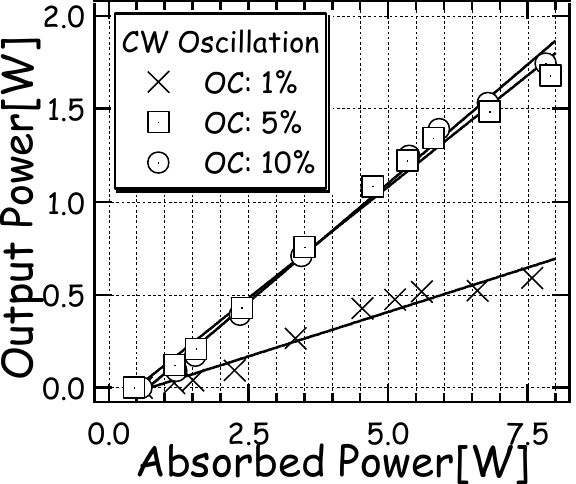
Figure 25. CW Output Power versus absorbed pump power for T = 1%, 5%, and 10%.